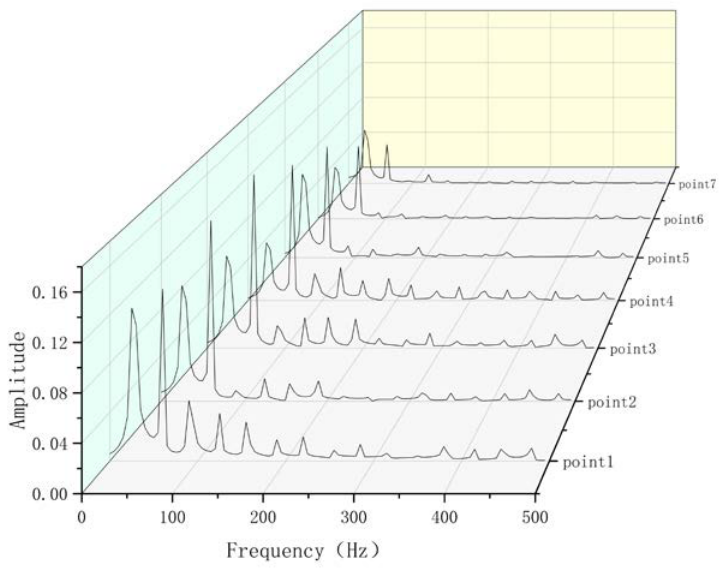
Figure 19. Pressure fluctuation in the area of hose recovery deformation calculated in the frequency domain when the outlet pressure is 0 MPa.